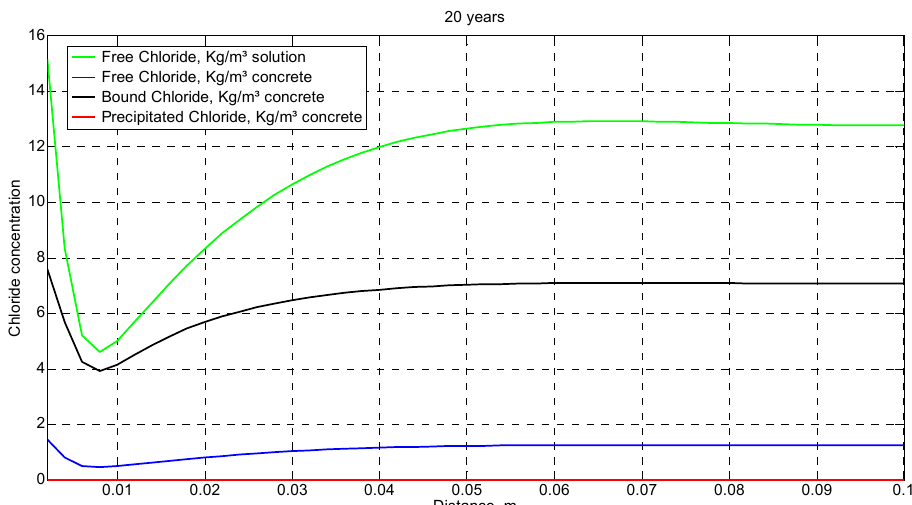
Figure 20. Spatial concentration of C f,s (free chloride in kg/m 3 solution), C f,c (free chloride in kg/m 3 concrete), C b (bound chloride in kg/m 3 solution) and C p (precipitated chloride in kg/m 3 concrete) after 1, 5, 7.9, 10 and 20 years.